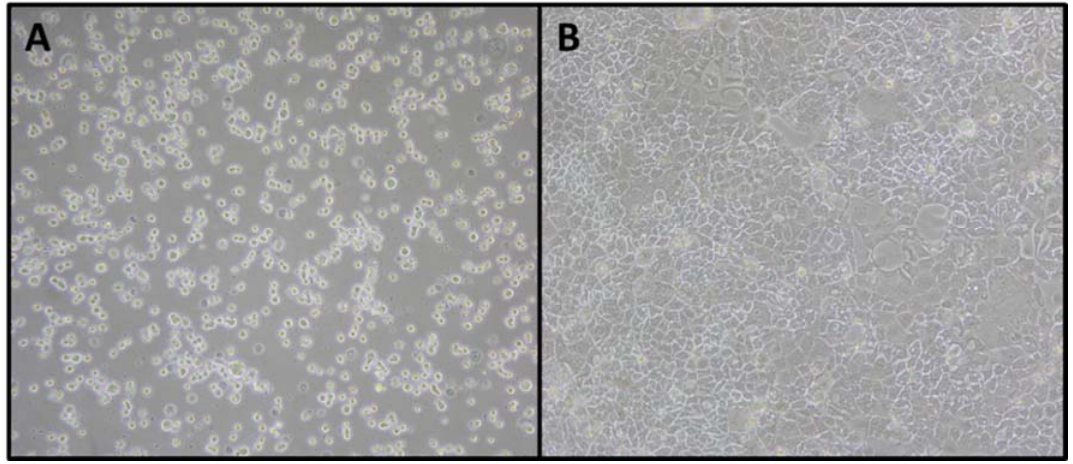
Figure 3. Unstained photographs of Caco-2 cells. ( A ) Immediately after seeding and ( B ) with 100% of confluence. Magnification: 100×.